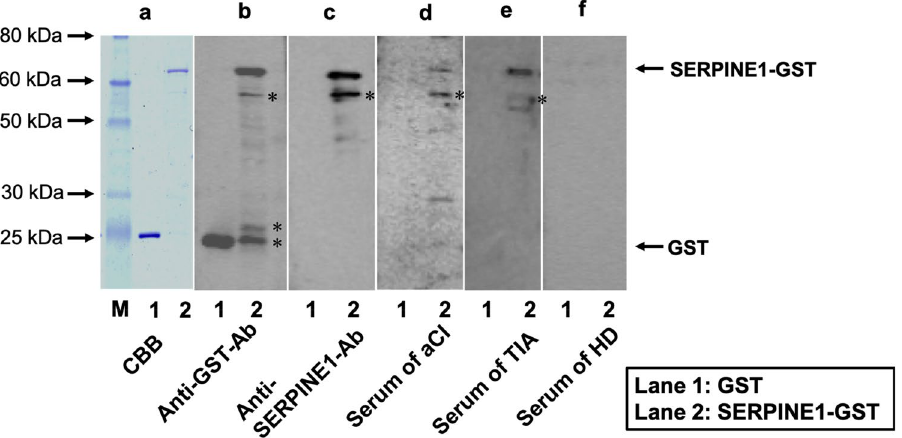
Figure 1. Western blot analysis. Affinity-purified glutathione- S -transferase (GST; lane 1) and GST-tagged full length SERPINE1 proteins (lane 2) were electrophoresed with sodium dodecyl sulfate–polyacrylamide (11%) gels, followed by staining with Coomassie Brilliant Blue. ( a ). Western blotting using anti-GST antibody ( b ) and anti-SERPINE1 antibody ( c ). Serum samples of patients with acute cerebral infarction (#7074) ( d ), a transient ischemic attack (#7096) ( e ), and of a healthy donor (#7021) ( f ). Electrophoresed molecular weight markers are also shown in ( a ) (lane M), and the sizes are shown in the left. The asterisk represents degradation products of SERPINE1 after electrophoresis. The number after # is the anonymized patient number and indicates which patient’s serum was used.